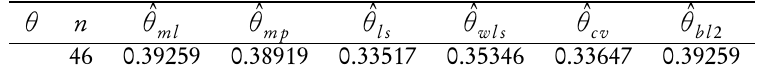
Estimate for the real dataset obtained by different methods of